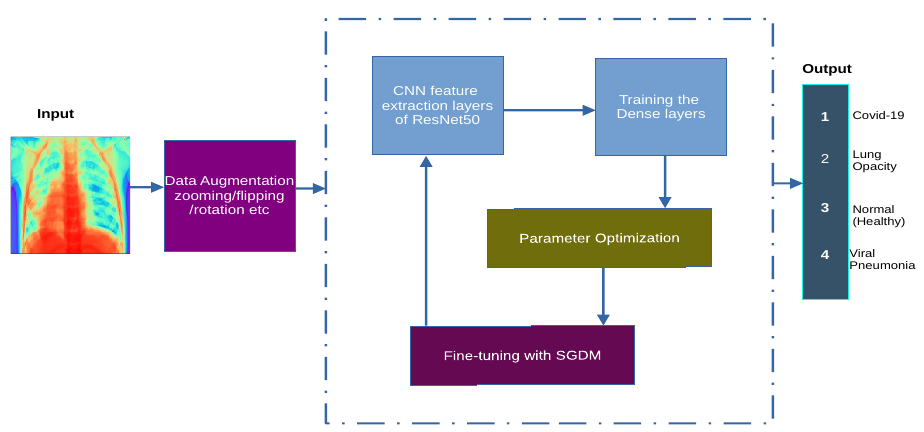
Figure 2. The schematic represents the proposed system model wherein the input is an RGB X- ray tensor, followed by a series of affine transformations. The next stage is a feedback latent feature extraction through convolution operations, classification in the dense layers preceded by non-linearities and parameter optimizations using SDGM. The four output classes are shown in the final stage of the